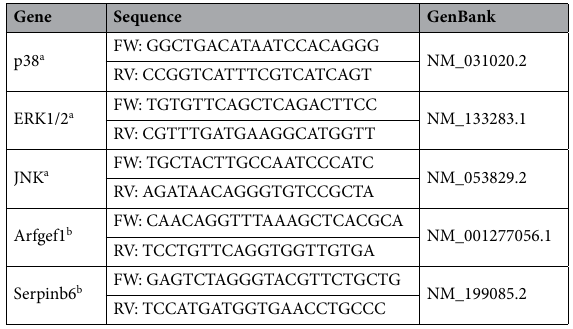
Table 2. 5’-3’gene sequences. FW forward; RV reverse. a Target genes; b